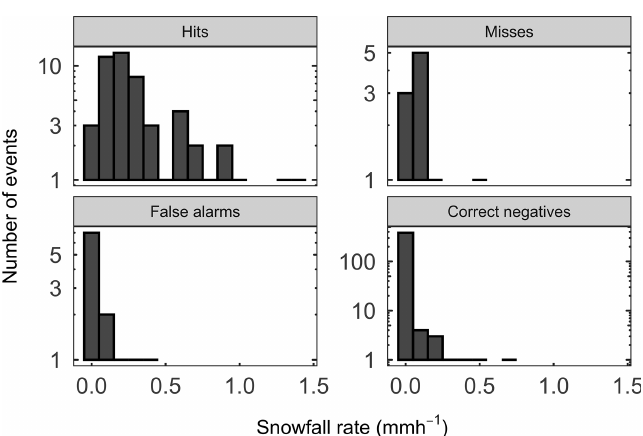
Figure A7. Snowfall rate by intervals measured optically during the events grouped by hits , misses , false alarms , and correct negatives based on the criterion running mean RH ice ≥ 97% throughout the lower 2.7km to predict snowfall. The y axis scale for each panel is different.